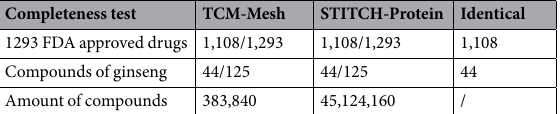
Table 3. Comparison of searching results between TCM-Mesh and STITCH. 1,293 FDA approved drugs and compounds of ginseng were searched in both databases and retrieved corresponding proteins, the searching results were shown in the table, and the number of compounds that could be searched in both databases was shown as identical. The size of both databases was for auxiliary